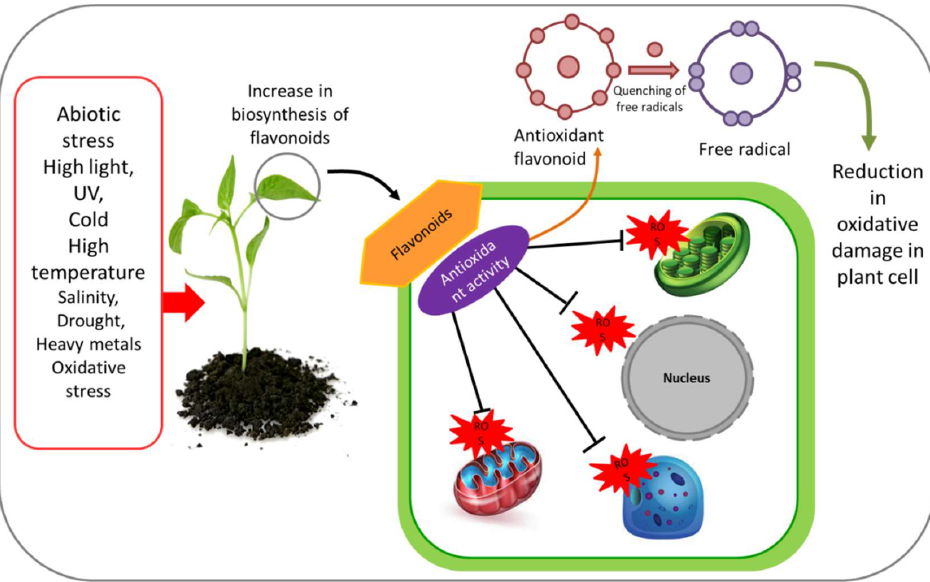
Figure 3. Antioxidant activities of flavonoids under abiotic stress. Following abiotic stress in plants, biosynthesis and accumulation of flavonoids takes part in reactive oxygen species (ROS) scavenging in different plant cell organelles and reduces oxidative damage in plant